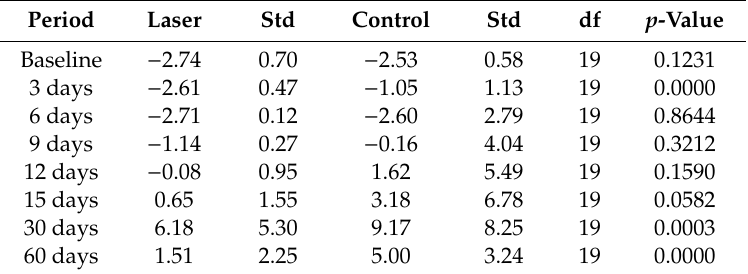
Std—standard deviation, df—degree of freedom. Std.—standard deviation, df—degree of freedom.